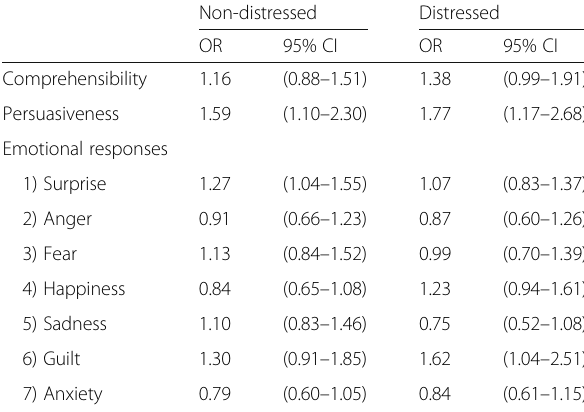
Table 5 Association between message assessment and increased help-seeking intention for depression among participants having no help-seeking intention before exposure to the